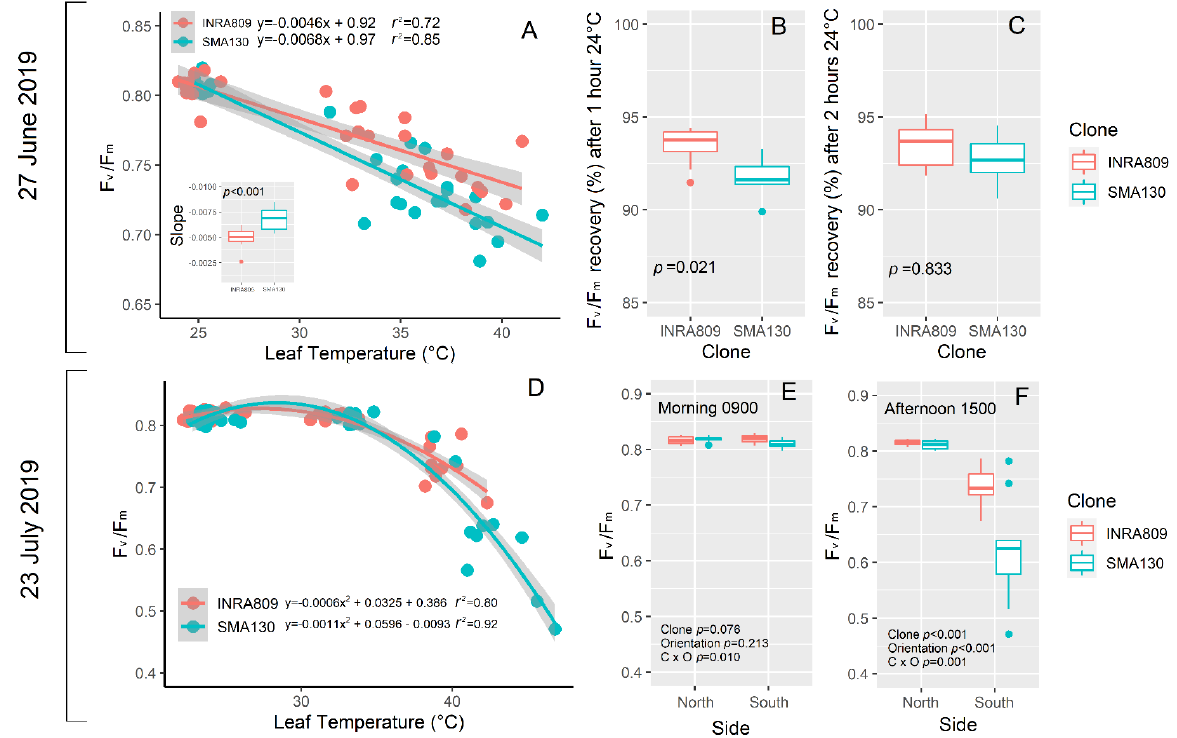
Figure 5. Relationship between leaf temperature (°C) and F v /F m in INRA809 and SMA130 ( A ). A linear regression was fit for each individual, and the slope was subjected to one-way ANOVA ( A ). In B and C, the % of F v /F m recovery compared to 25 °C leaf temperature condition is shown after 1 h ( B ) and 2 h ( C ). Data were collected on 27 June 2019 (n = 5 – 10) and subjected to one-way ANOVA. In ( D ), the relationship between leaf temperature (°C) and F v /F m in INRA809 and SMA130 is shown. A second-order polynomial curve was fit to the data. In ( E , F ), the F v /F m collected either in the morning ( E ) and in the afternoon ( F ) in INRA809 and SMA130 is shown. Analysis was carried out on both the side of the raw ( n = 10), and data were subjected to two-way ANOVA (output in the graph).